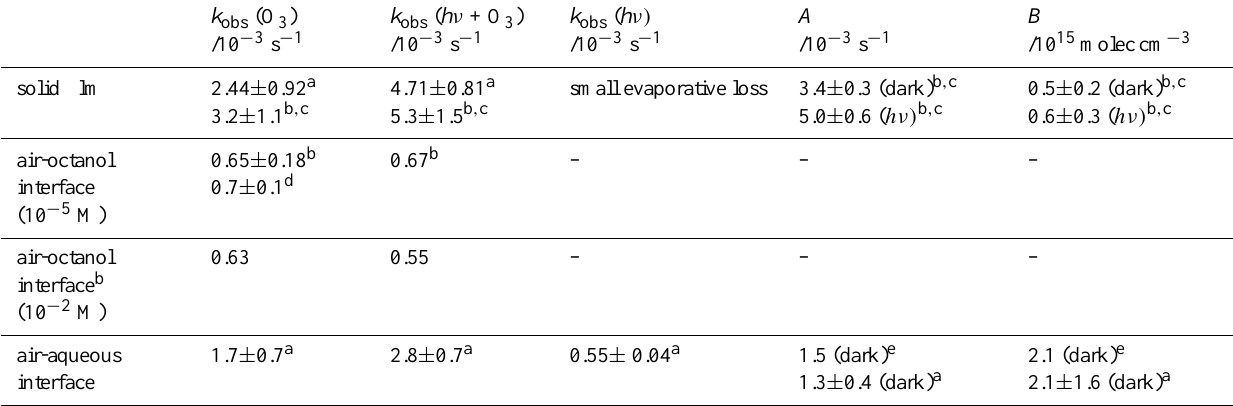
Table 1. Kinetic parameters for pyrene loss as a function of proxy